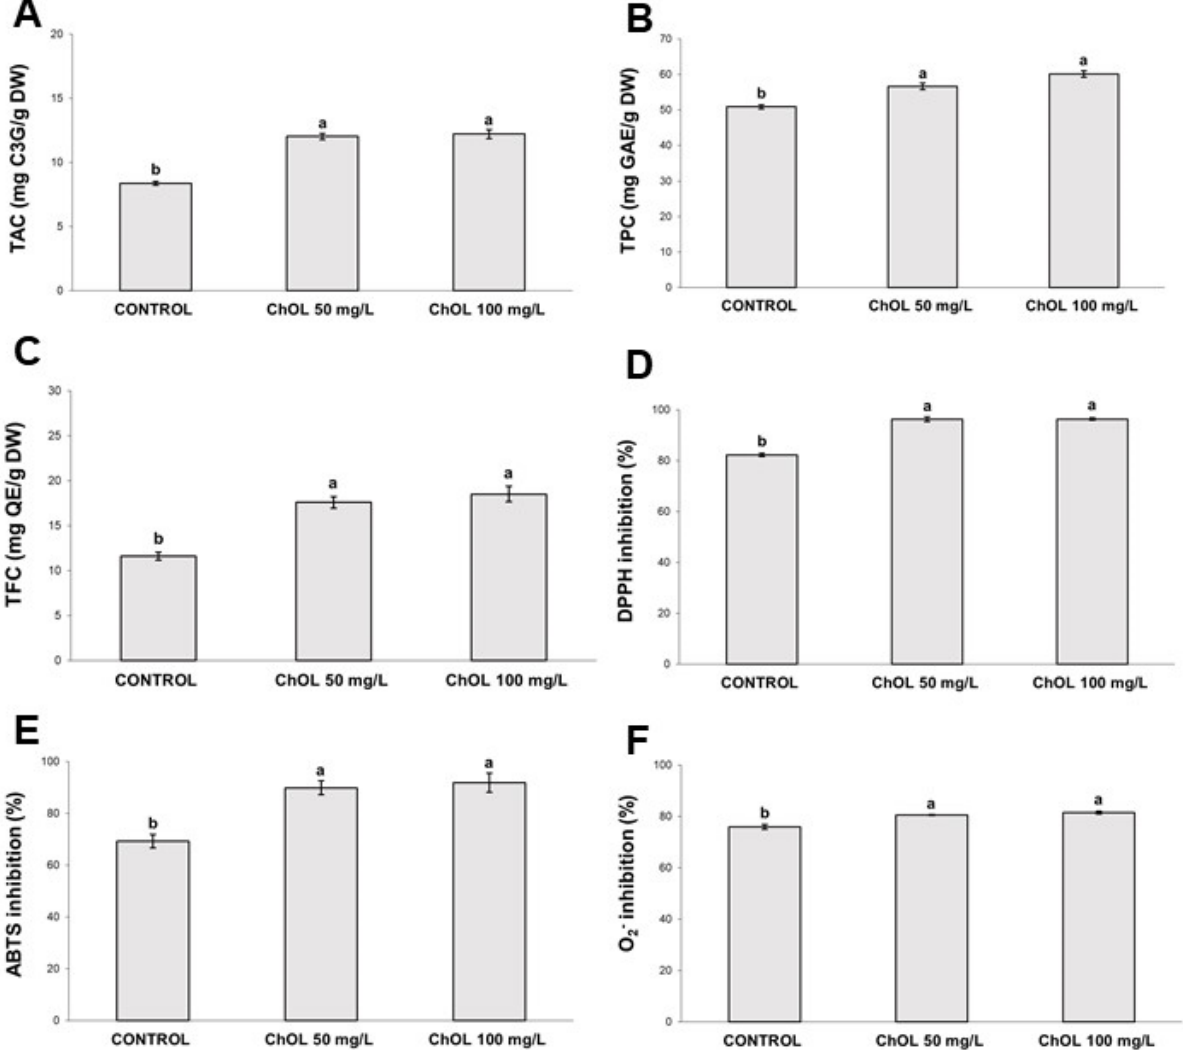
Figure 4. Effects of chitosan oligosaccharide lactate (ChOL) on ( A ) total anthocyanin content (TAC); ( B ) total phenolic content (TPC); ( C ) total flavonoid content (TFC) and antioxidant activities: ( D ) DPPH, ( E ) ABTS and ( F ) O 2 − inhibition of red perilla . Bars represent the average and error bars show standard errors of the mean. Different letters above and below bars indicate significant differ- ences at p ≤ 0.05. C3G: cyanidin-3-glucoside equivalent; GAE: gallic acid equivalent; QE: quercetin equivalent; DW: dry weight; DPPH: (1,1-diphenyl-2-picryl-hydrazyl); ABTS: 2.2 ′ -azino-bis(3- ethylbenzothiazoline-6-sulfonic acid) diammonium salt.